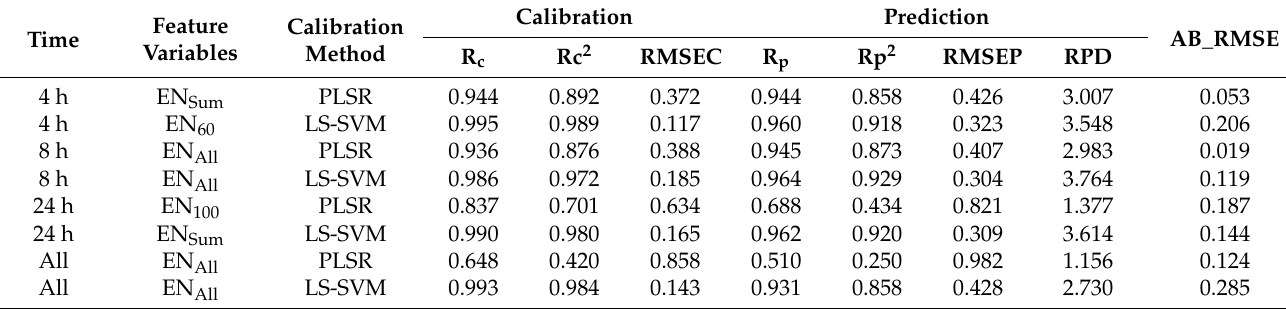
Table 1. Best models for the prediction of the extent of impact damage in strawberries at different storage times (4, 8, and 24 h) after being impacted and all kinds of storage times. Correlation coefficient of calibration (Rc), root-mean-square error of calibration (RMSEC), correlation coefficient of prediction (Rp), root-mean-square error of prediction (RMSEP), residual predictive deviation (RPD), and the absolute difference between RMSEC and RMSEP